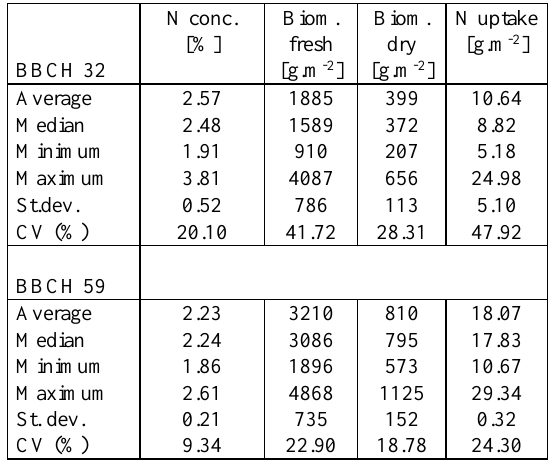
Table 1. Basic statistics of results of plant analysis (St. dev. – standard deviation, CV – coefficient of variability, N conc. –